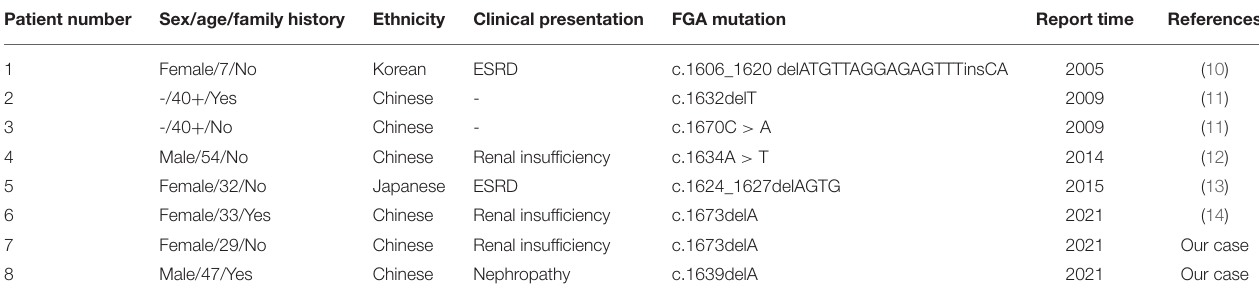
TABLE 2 | Clinical presentation and gene mutation of AFib amyloidosis patients in